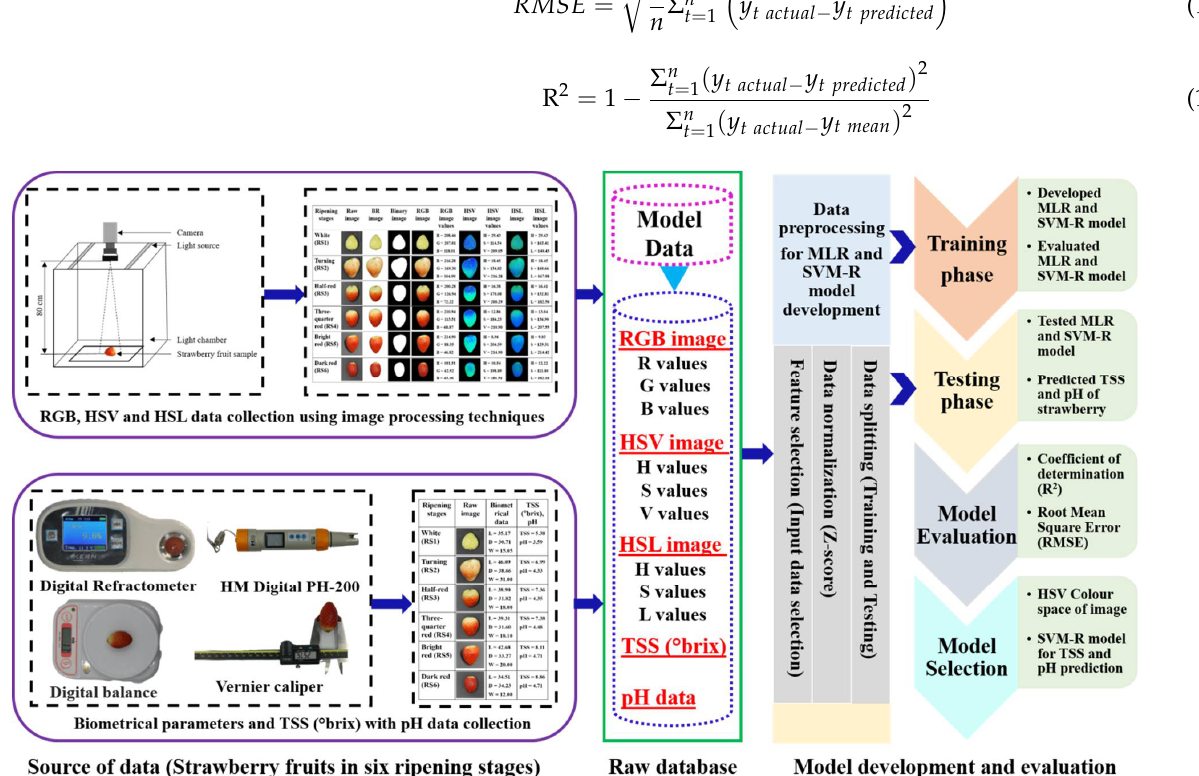
Figure 4. Flow diagram of prediction of total soluble solids (TSS) and pH content of strawberries in six ripening stages with RGB, HSV and HSL colour spaces using multiple linear regression (MLR) and support vector machine regression (SVM-R).